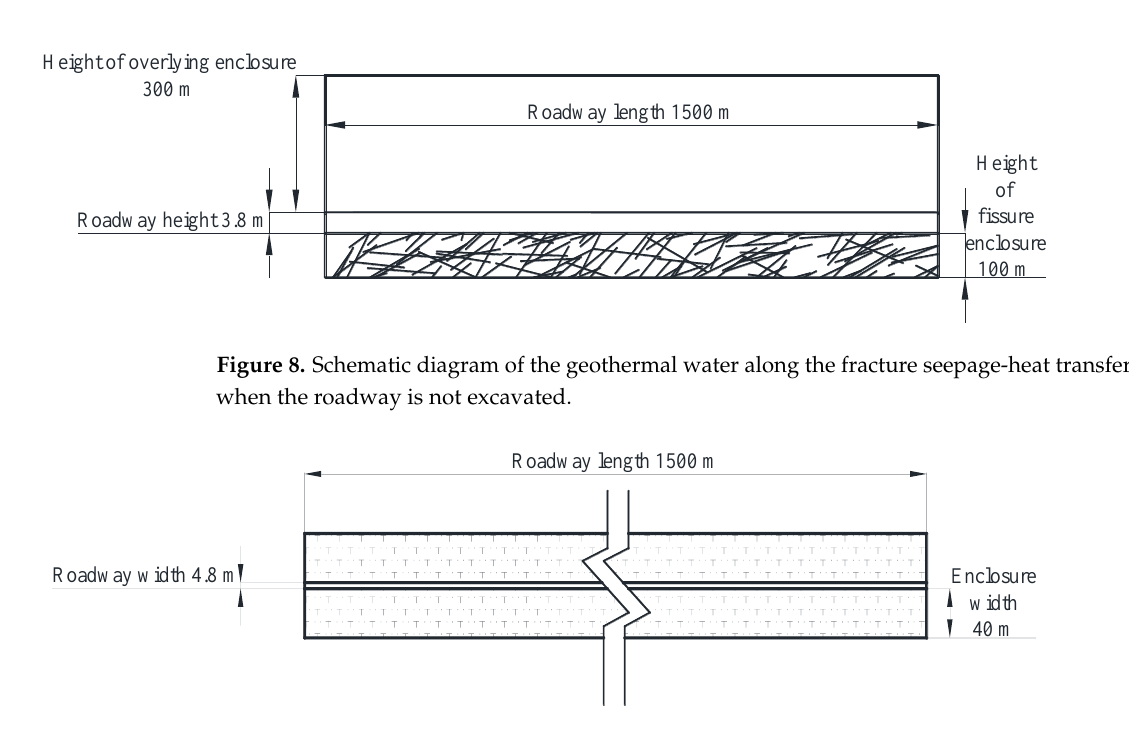
Figure 9. Schematic diagram of the coupled seepage-heat transfer and convective heat exchange horizontal model after excavation of the roadway.